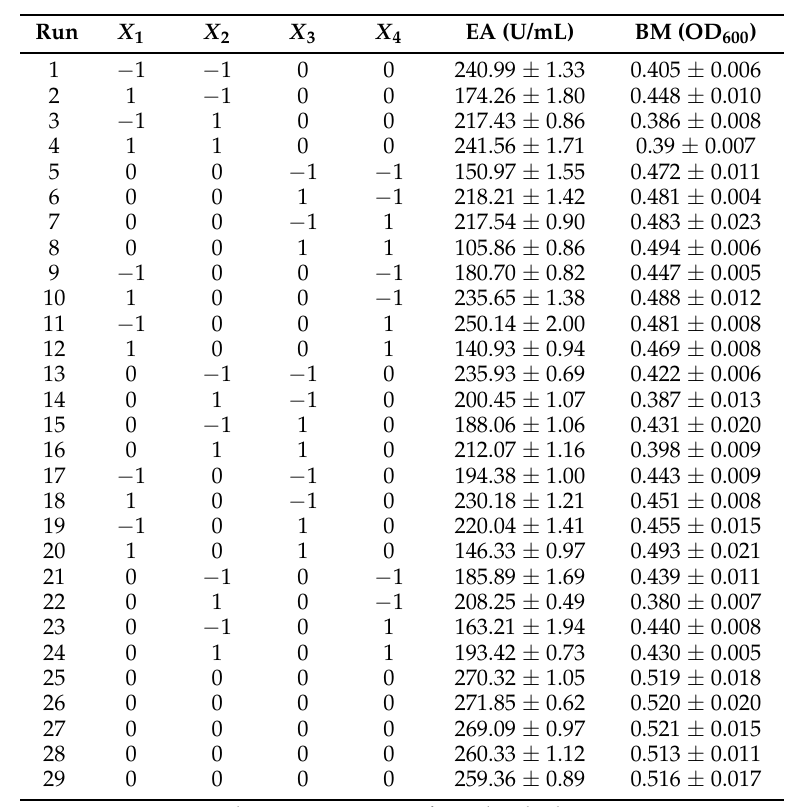
Table 4. Experiment design and result of response surface analysis.